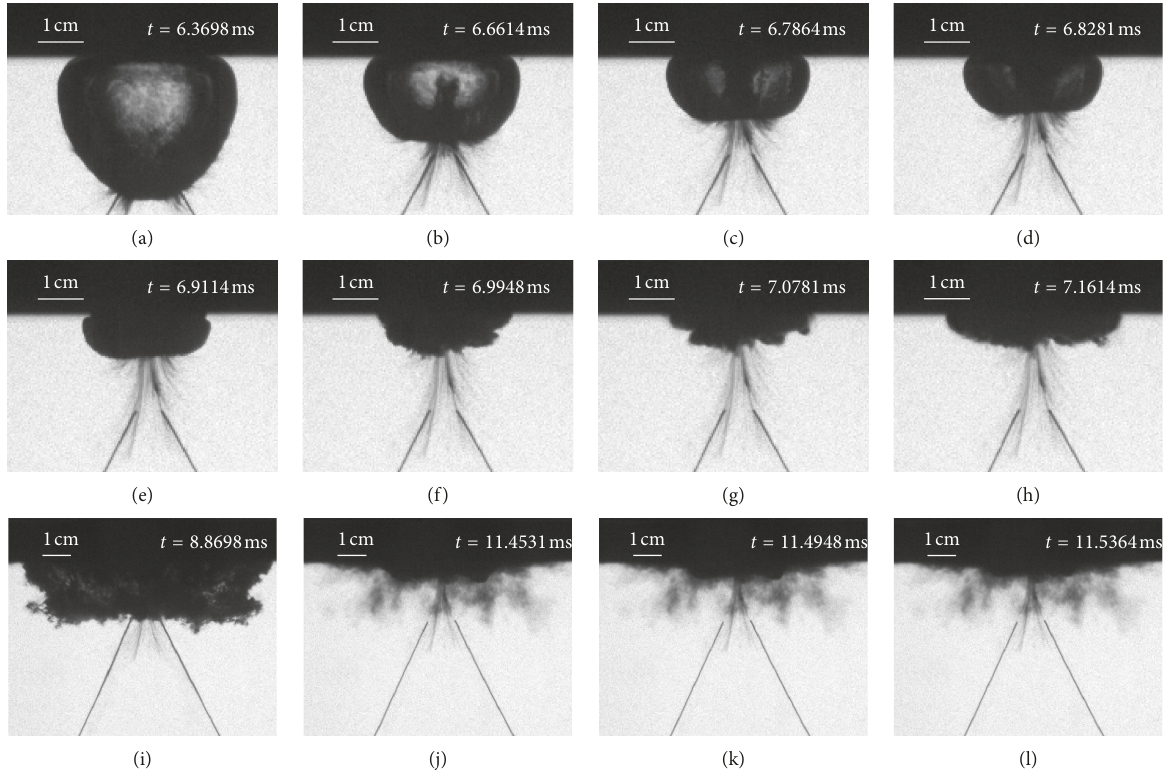
Figure 13: Evolution of the first cycle of the underwater spark-generated bubble’s expansion and collapse below the target plate with 25mm standoff. (a) t � 6.3698ms. (b) t � 6.6614ms. (c) t � 6.7864ms. (d) t � 6.8281ms. (e) t � 6.9114ms. (f) t � 6.9948ms. (g) t � 7.0781 ms. (h) t � 7.1614ms. (i) t � 8.8698ms. (j) t � 11.4531ms. (k) t � 11.4948 ms. (l) t �